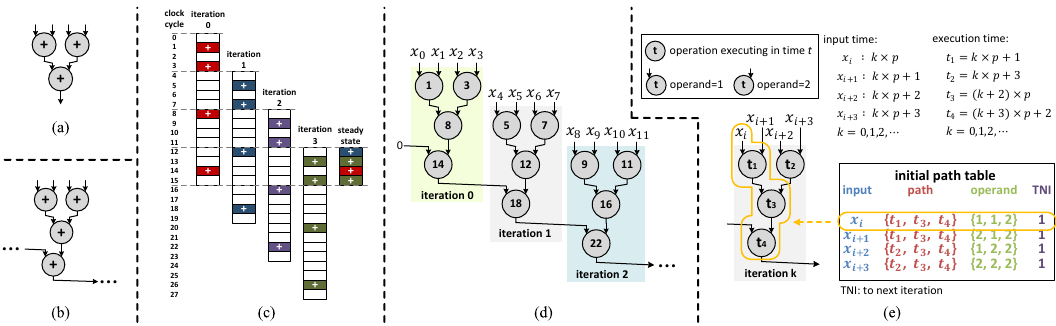
Figure 5. An example of the Algorithm 1, where p = 4. ( a ) binary tree; ( b ) binary tree with an addition used to add the previous partial result; ( c ) software pipeline; ( d ) data flow graph marked with the clock cycle of each operation; ( e ) initial path table of iteration k .